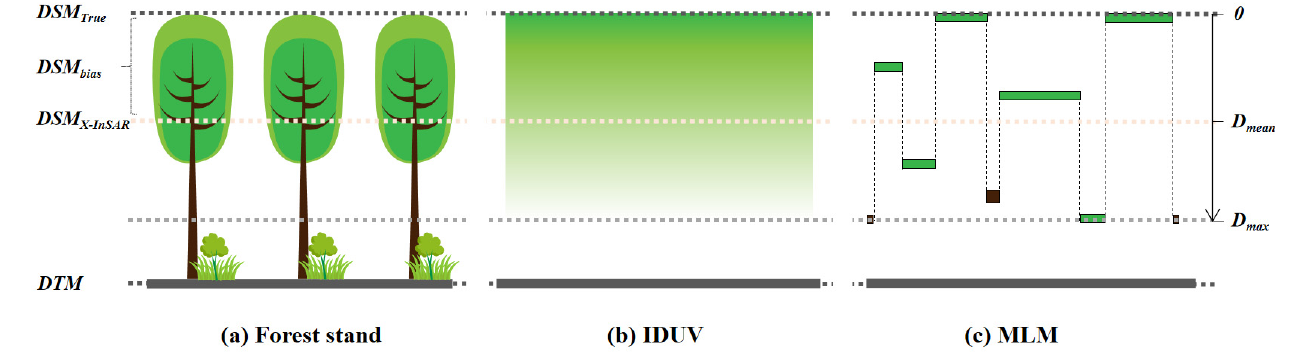
Figure 4. The bias ( DSM bias ) between the DSM extracted by X-InSAR ( DSM X-InSAR ) and the real DSM ( DSM True ), and the different mechanistic models describing the penetration of X-band InSAR into the forest: ( a ) Forest stand; ( b ) Infinitely deep uniform volumes (IDUV) model; ( c ) Multilevel model (MLM).